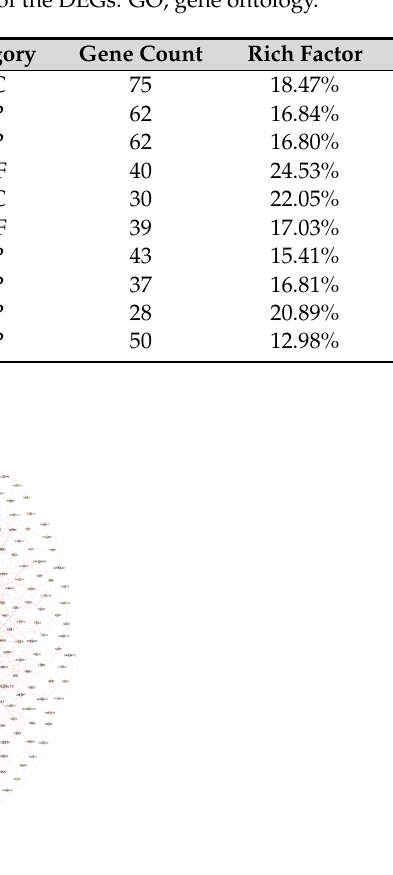
Table 4. Top 10 GO enrichment analyses of the DEGs. GO, gene ontology.